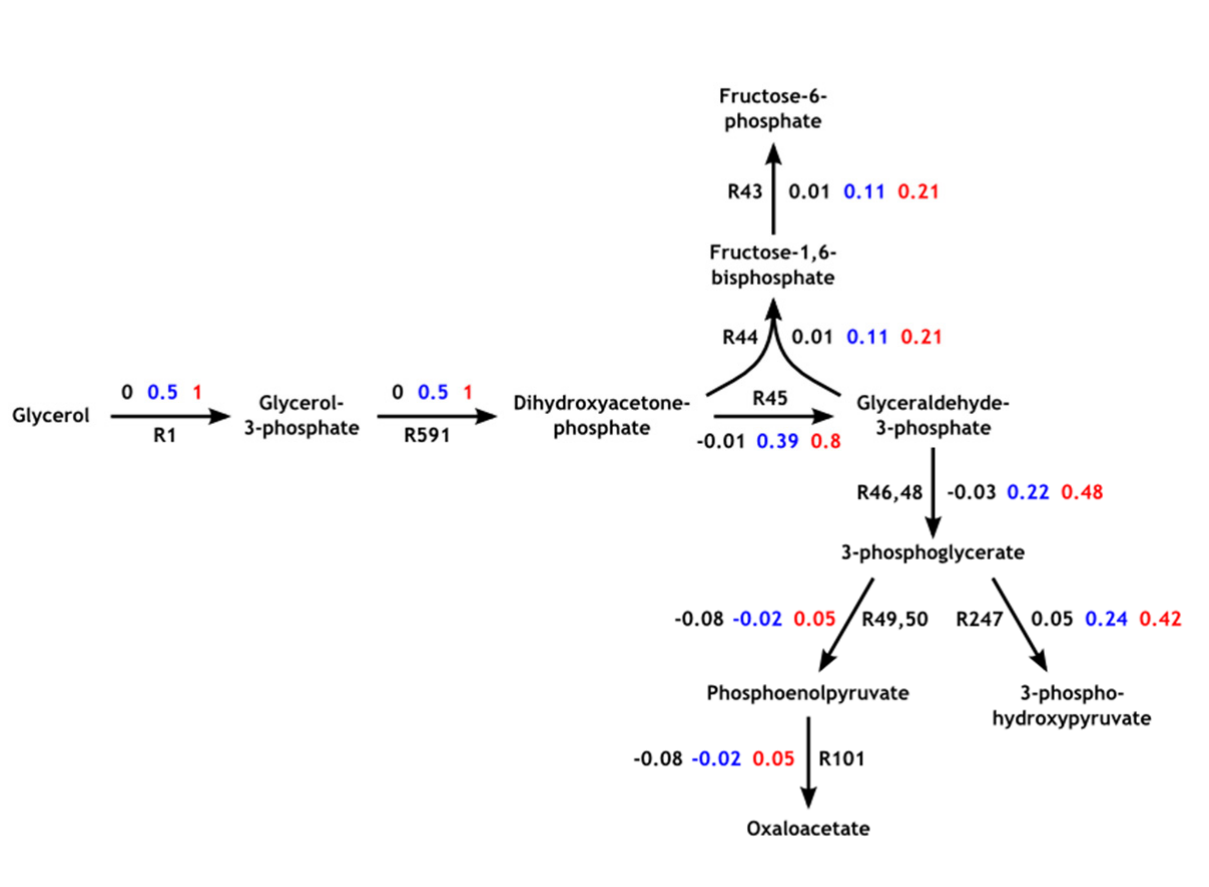
Figure 2. Main response of Mycobacterium tuberculosis to glycerol uptake rates at 0, 0.5 and 1.0 mmol/gDW/h. The network shows a selected set of reactions in the central metabolic pathways of M. tuberculosis . Reactions are represented using arrows and the positive direction of flux is indicated by the direction of the arrow (reaction reversibility is not represented). Numbers next to the arrows indicate flux values with black, blue and red colours corresponding to a glycerol uptake rate of 0, 0.5 and 1.0 mmol/gDW/h respectively; black numbers starting with R represent reaction